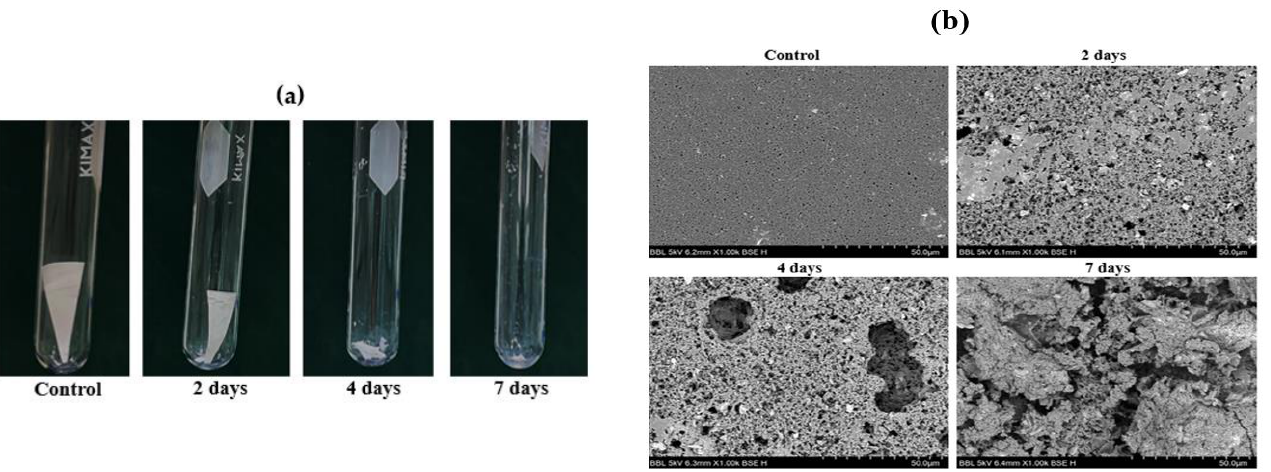
Figure 3. Degradation of poly(3-hydroxybutyrate) (PHB) and residual PHB film by Microbulbifer sp. SOL66. ( a ) The residual PHB films were collected on days 3, 5, and 7. ( b ) The surface of the degraded PHB film was observed using scanning electron microscopy (SEM) with magnified images.